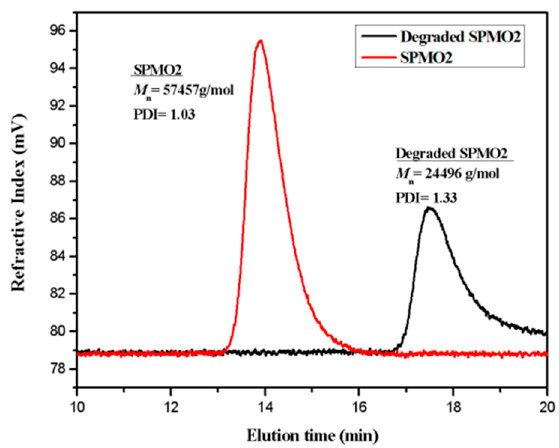
Figure 3. Size exclusive chromatography (SEC) traces of SPMO2 polymer without and with 10 mM dithiothreitol (DTT).